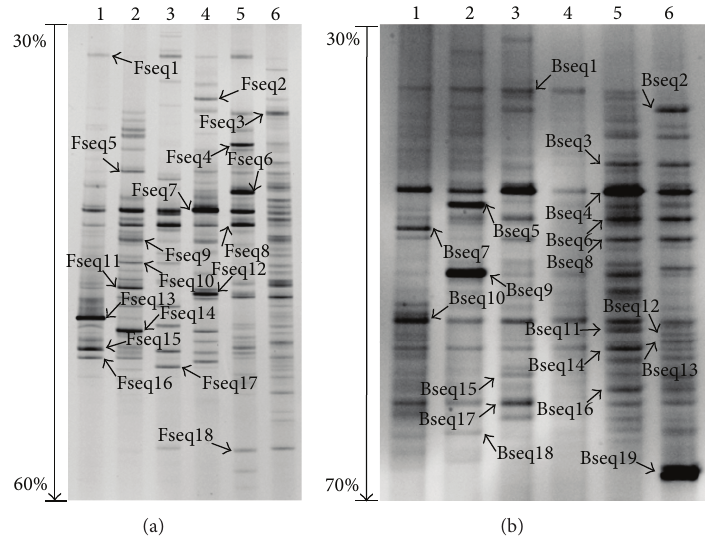
Figure1:DGGEpatternsoffungalandbacterialcommunitiesintherhizosphereof Pinus tabulaeformis .(a)Fungalcommunitystructureafter PCR amplification using primer pair ITS1-F-GC/ITS2 and DGGE. (b) Bacterial community structure after PCR amplification using